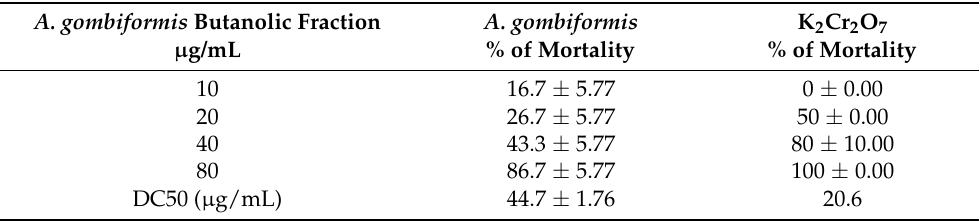
Table 4. Brine shrimp lethality bioassay of butanolic fraction extracted from A. gombiformis compared to K 2 Cr 2 O 7 used as